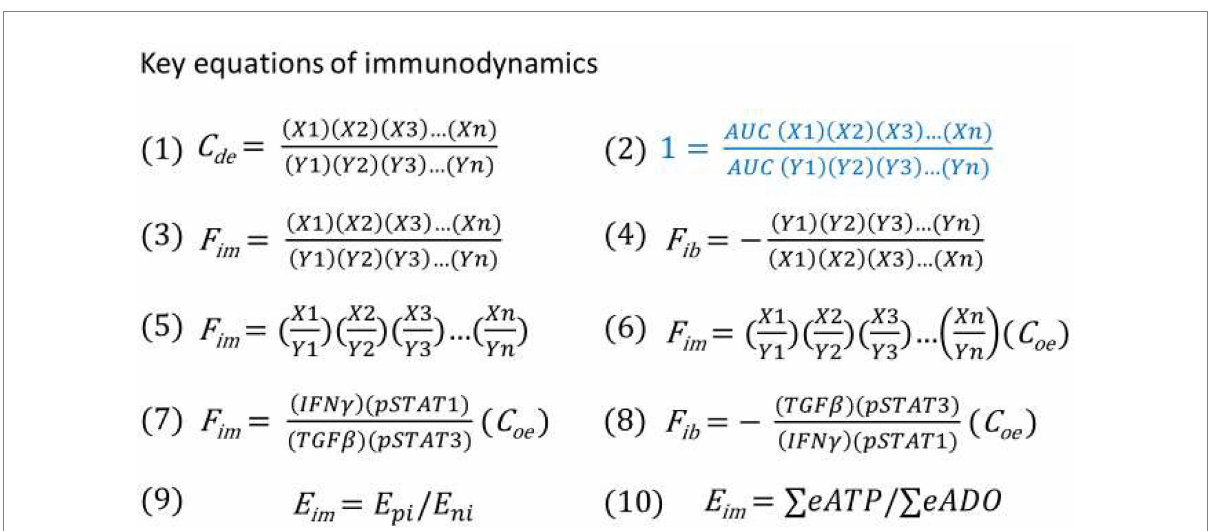
FIGURE 4 (1) Immune dynamic equilibrium equation. (2) The equation for thought experiments based on the postulate (regardless of correct or not) that the AUC of the positive and negative immune power was equal throughout the entire immune response. (3) Theoretical immune force equation when positive immune power > negative immune power. (4) Theoretical immune braking force equation when negative immune power > positive immune power. (5) Immune force equation from equation (3) after conducting factor pair equivalent transformation. (6) Immune force equation obtained